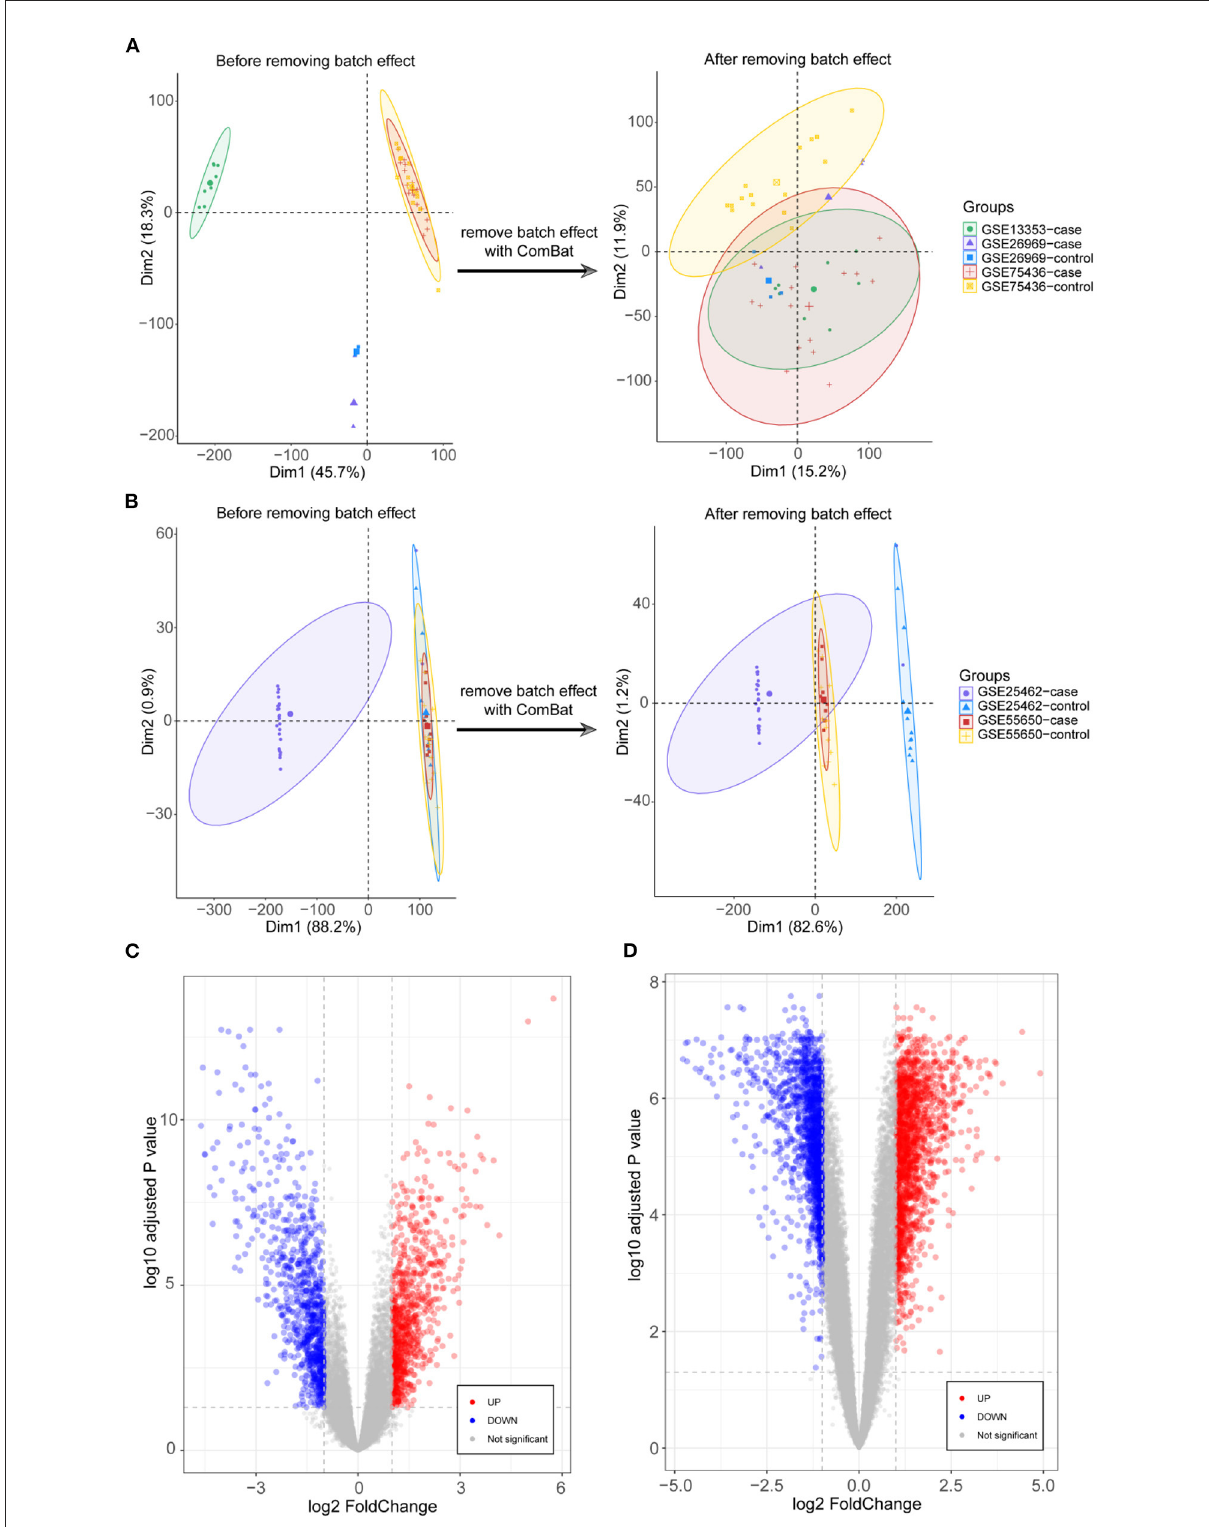
FIGURE1 Integration of datasets and differential expression analysis. (A) First and second principal components of the intracranial aneurysm (IA)—GSE13353, GSE26969, and GSE75436 datasets before and after eliminating the batch effects. (B) First and second principal components of the type 2 diabetes mellitus (T2DM)—GSE25462 and GSE55650 datasets before and after eliminating the batch effects. (C) Volcano plots of differentially expressed genes (DEGs) in IA and T2DM. (D) Volcano plots of DEGs in